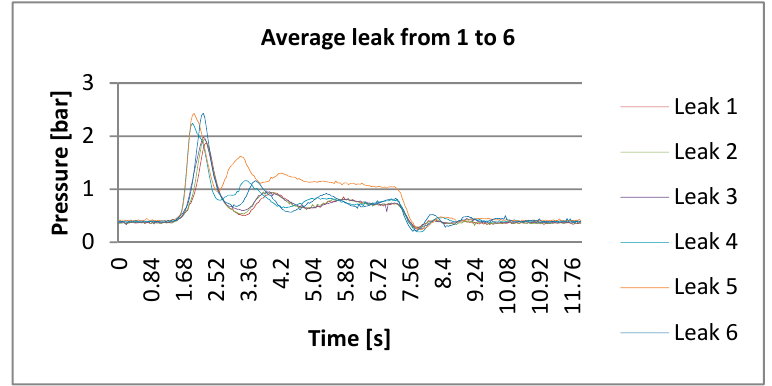
Figure 7. Recorded trends of opening and closing taps for simulating leaks from 1 to 6.